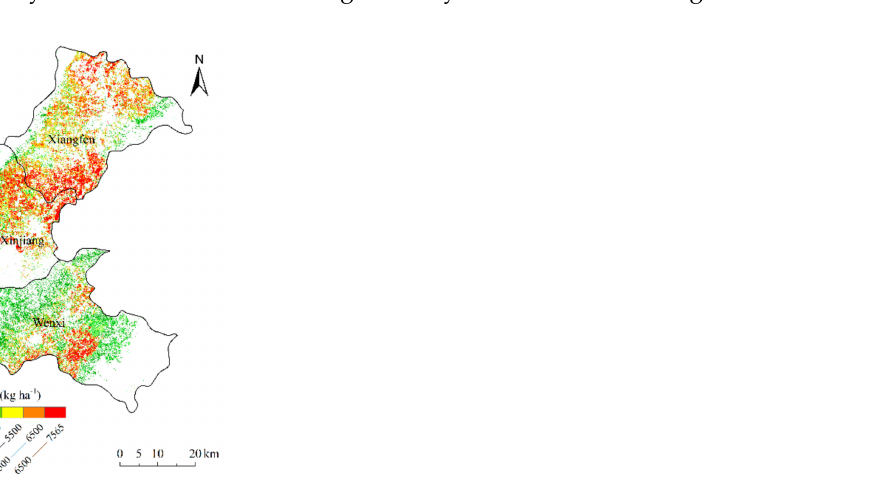
Figure 8. Yield distribution of winter wheat in Xiangfen, Xinjiang, and Wenxi county in